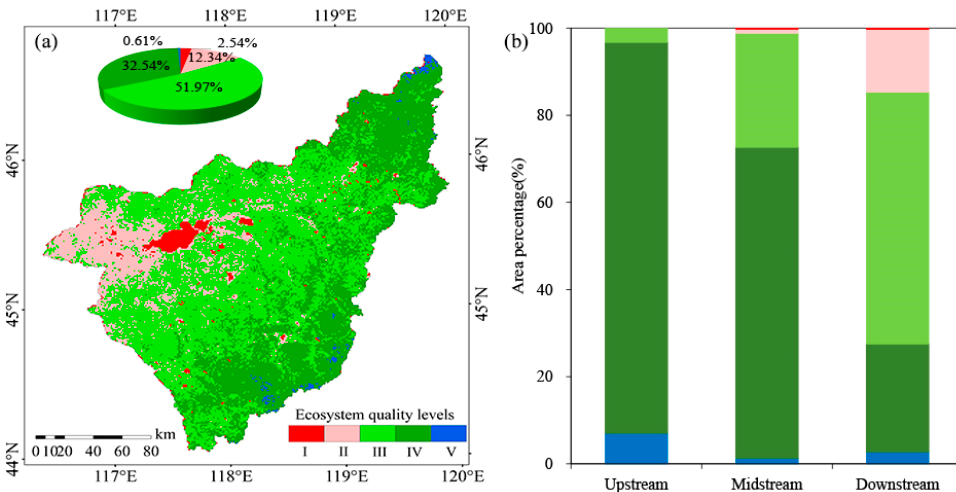
Figure 6. Ecosystem quality levels ( a ) and its area proportion in different river segments ( b ) in the URB from 2001 to 2019.